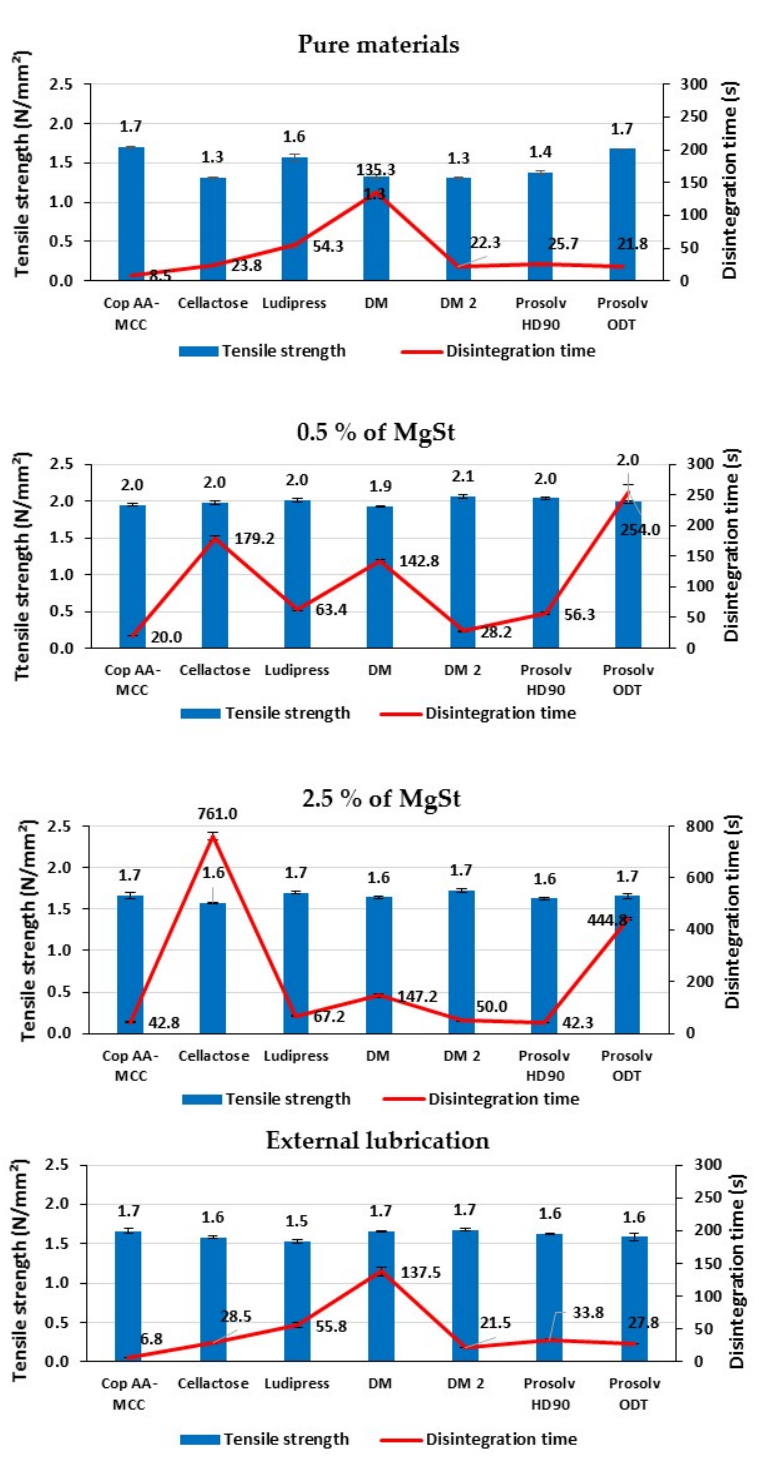
Figure 8. Effect of internal lubricant concentration and external lubrication (EL) on tablet disintegration time of the different studied materials.